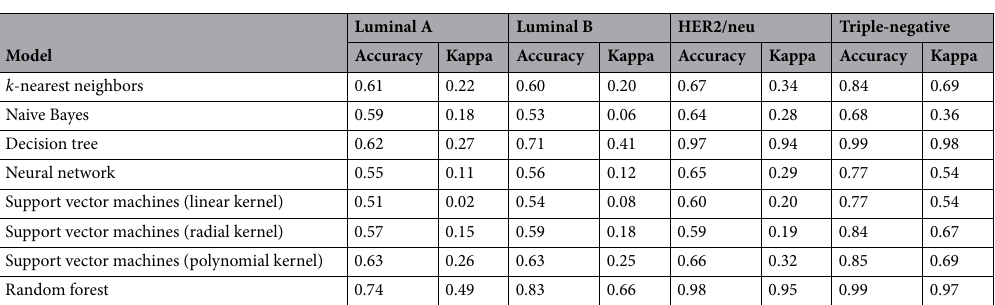
Table 3. Leave-one-out cross-validated discrimination accuracy and reliability of molecular phenotyping of breast cancer using machine learning algorithms.